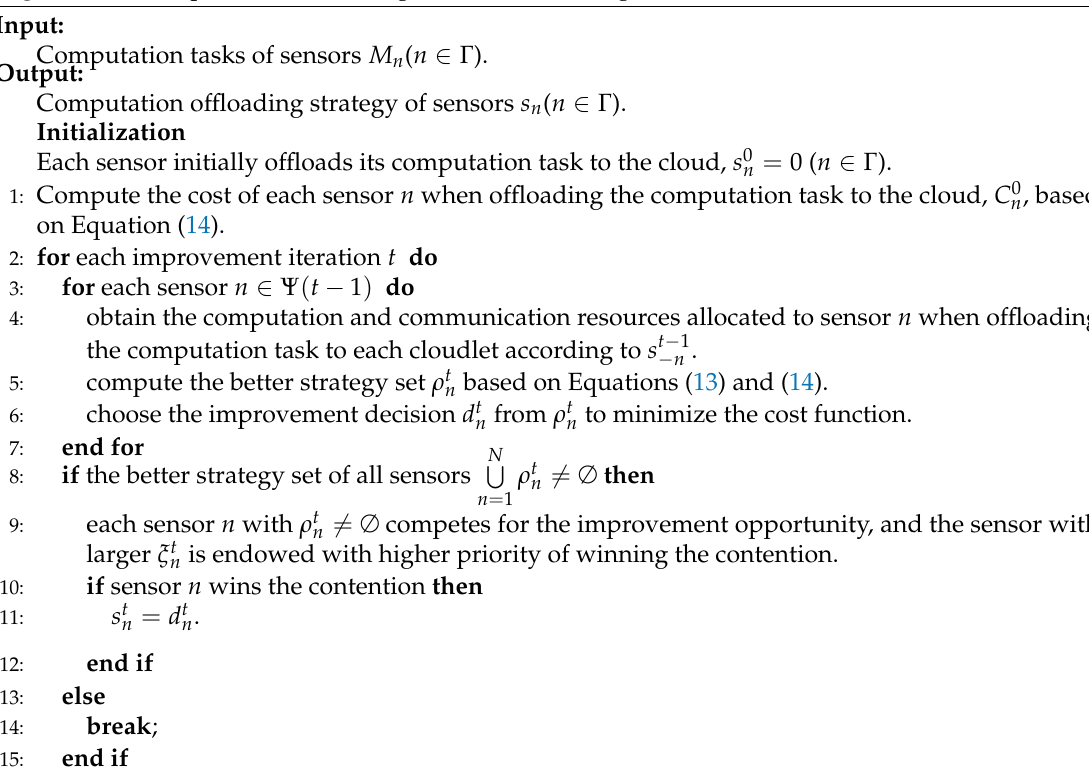
Algorithm 1 Computation Offloading Decision (COD)